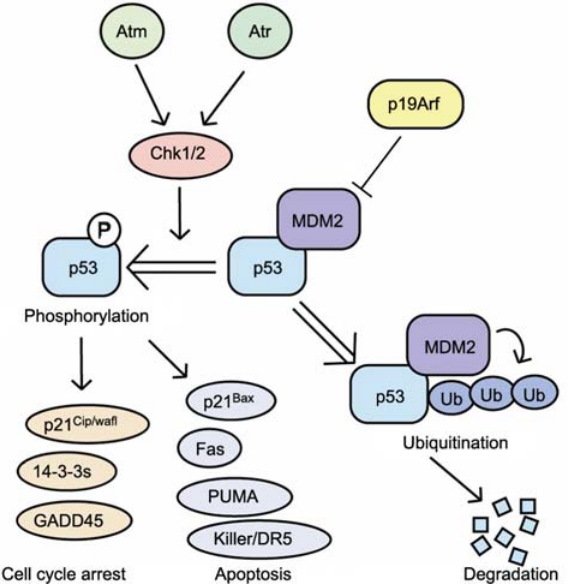
Figure 3 The Arf-p53 pathway.